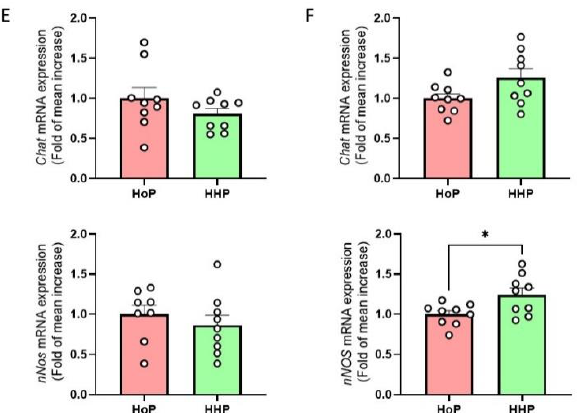
Figure 4. Chronic oral HHP milk treatment decreases ileal contraction amplitude. Ex vivo measure- ment of duodenum ( A ), jejunum ( B ), ileum ( C ) and colon ( D ) mechanical contraction amplitude and frequency in response to chronic oral treatment with HoP- or HHP-BM (100 µL/day during one week; n = 8 – 10 per group). Expression of nNos and Chat mRNAs in the duodenum ( n = 9) ( E ) and in the ileum ( F ). * p < 0.05 compared to HoP-BM treated mice.